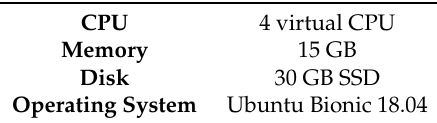
Table 1. Cloud instance specifications.